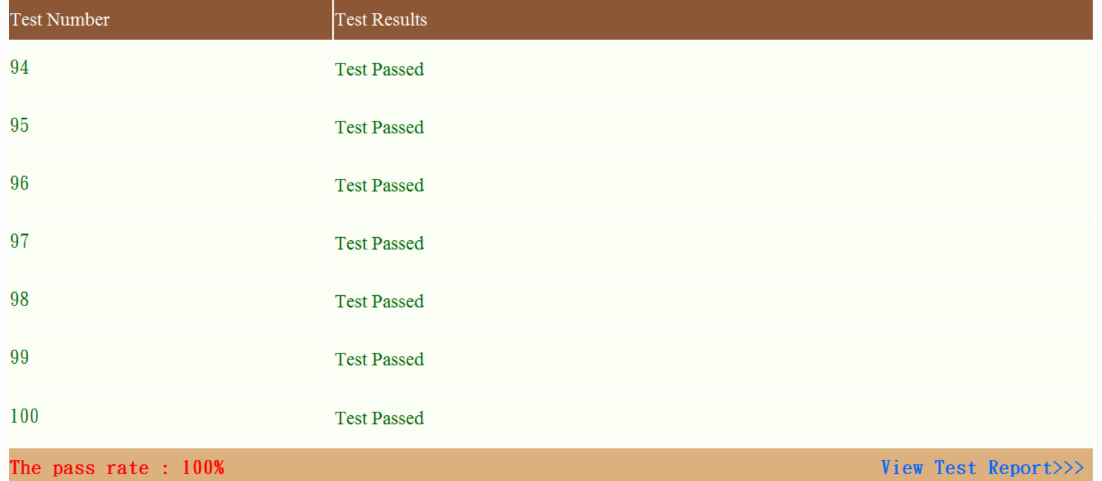
Figure 33. Test result after modifying program